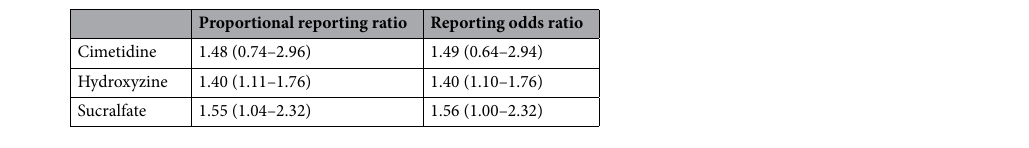
Table 2. External validation of ototoxicity signal in FDA adverse event reporting system